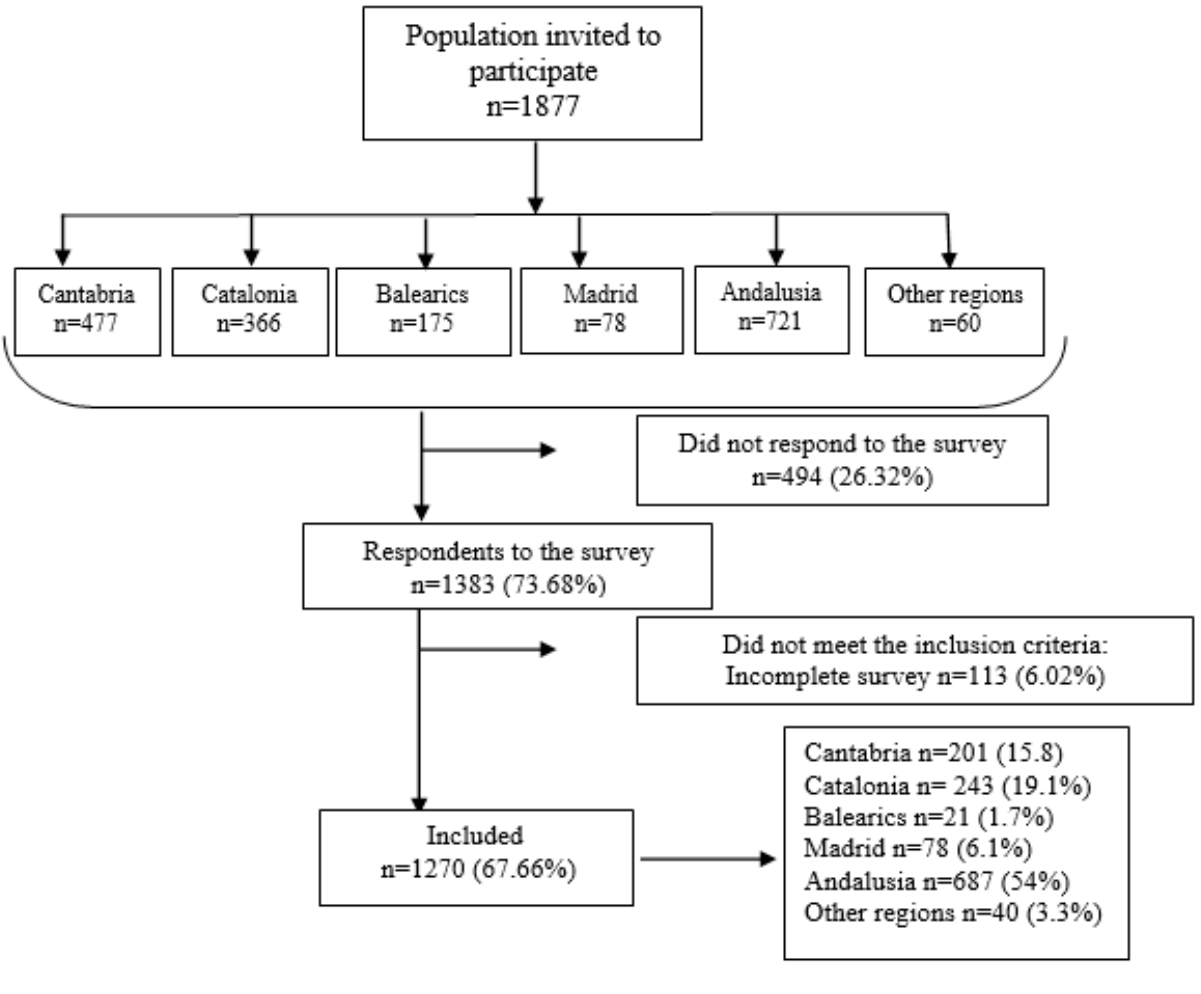
Figure 2. Participants’ flowchart.